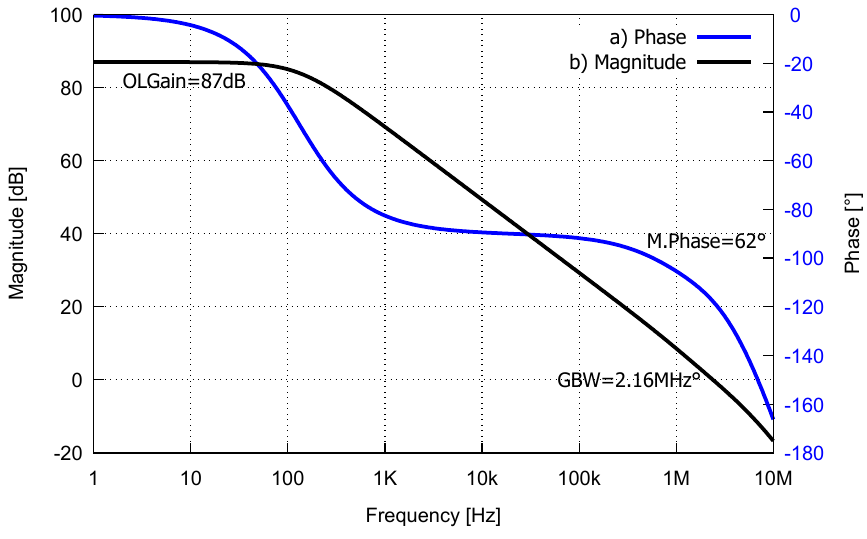
Figure 6. OPAMP frequency